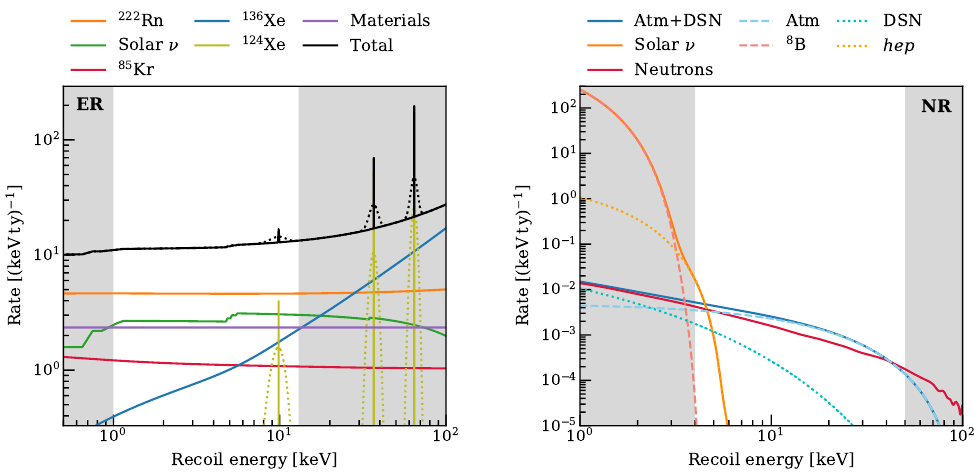
Figure 6. Energy spectra of ER ( left ) and NR ( right ) backgrounds expected in a core 4 t fiducial mass of the XENONnT detector. The white areas highlight the RoI for the standard SI WIMP search: (1, 13) and (4, 50) keV for ERs and NRs, respectively. The rate shown from 222 Rn (orange line) assumes 1 µBq/kg activity concentration, while a 0.1 ppt concentration of natural Krypton in the LXe target is responsible for the 85 Kr component (red). The dotted lines represent the Gaussian smearing of mono-energetic lines according to the energy resolution achieved in XENON1T [78]. The sources of NR background are distinguished into radiogenic neutrons (red), solar neutrinos (orange), and atmospheric (dashed blue) and diffuse supernova neutrinos (dotted blue). The neutron rate accounts for an expected 87% suppression thanks to the XENONnT’s neutron veto system. Image from Ref.